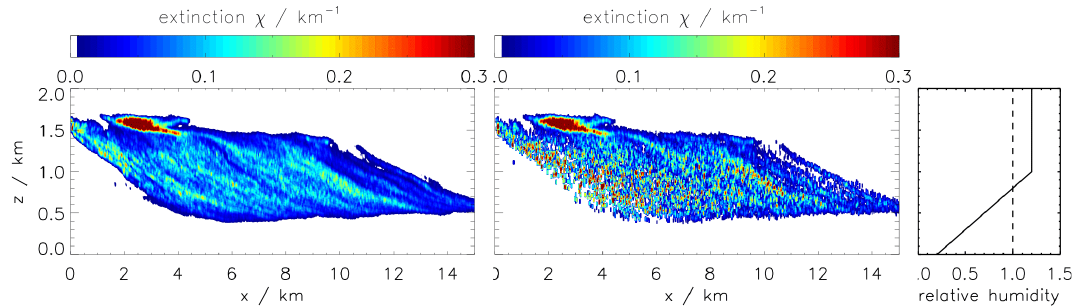
Fig. 2. Extinction of 4h-old contrail-cirrus with high SIP number (left, Run A1 S ) and low SIP number (middle, Run A4). The right panel shows the initial vertical profile of the relative humidity. Parameter settings of the simulations are listed in Tables 1 and 2.